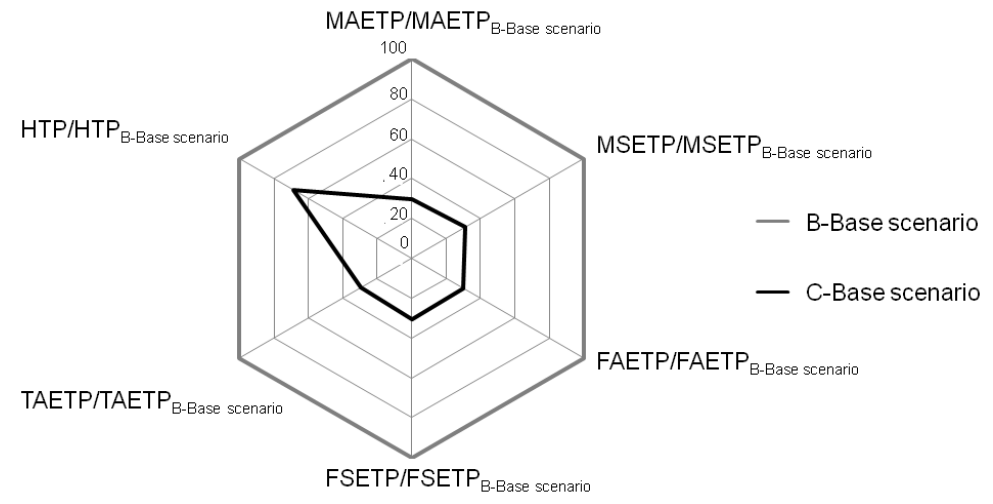
Figure 3. Toxicity potentials of batch and micro-/milli-continuous